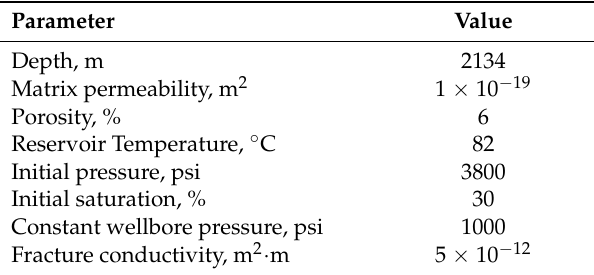
Table 3. Reservoir Table 3. Reservoir parameters